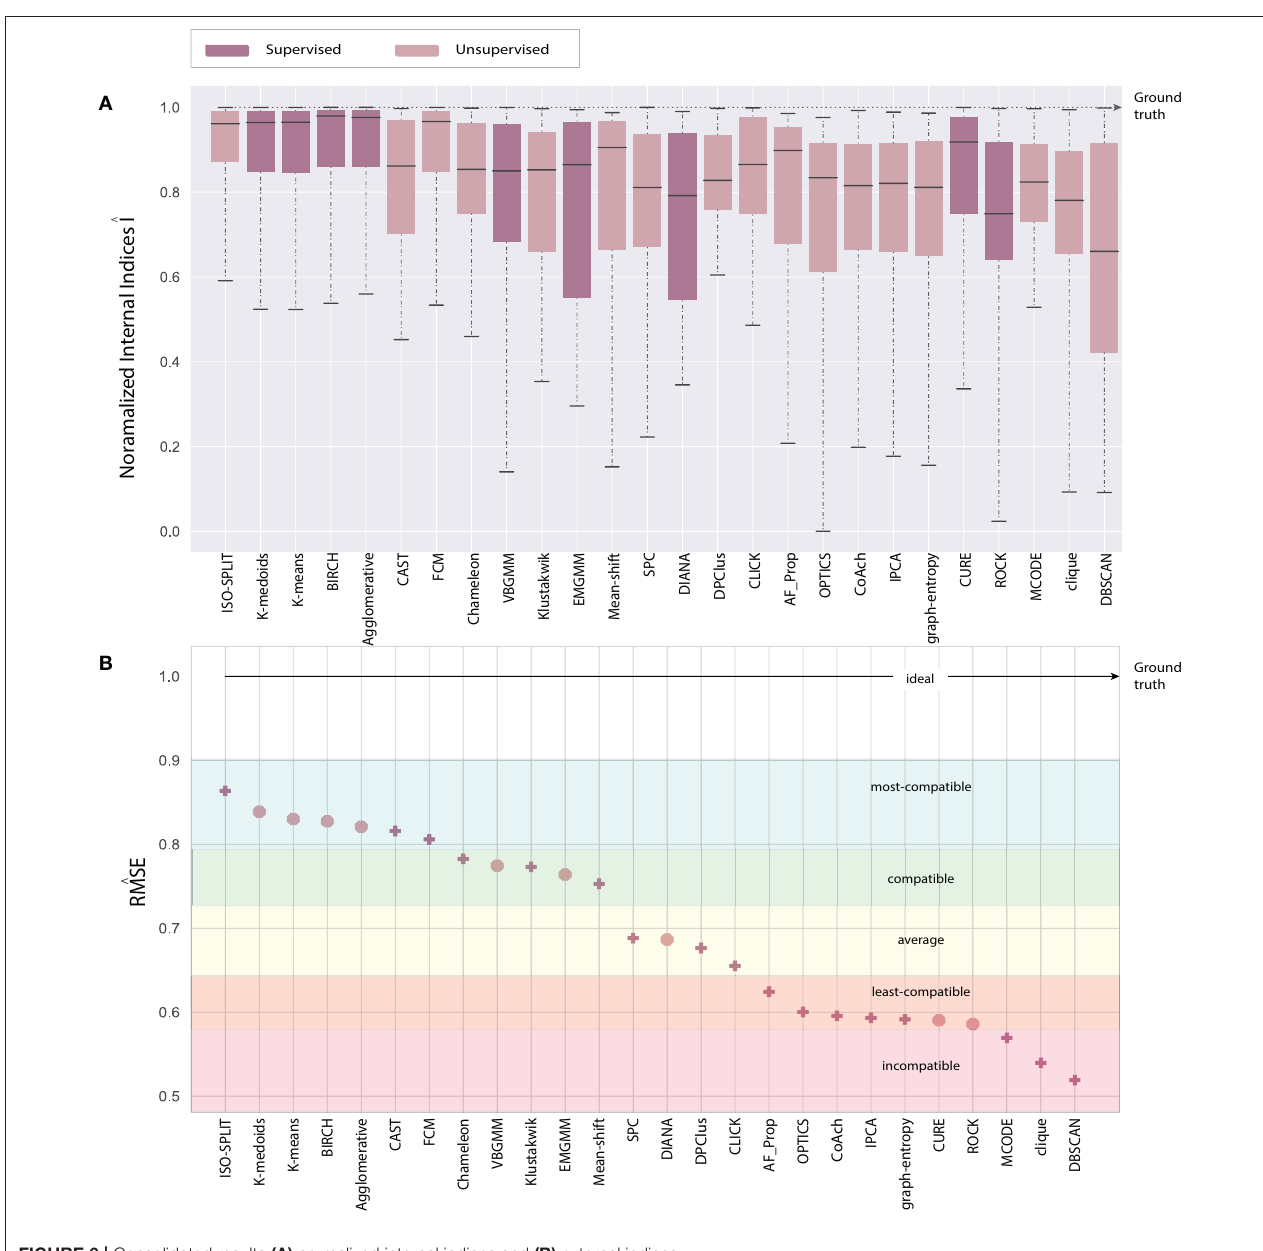
FIGURE 6 | Consolidated results (A) normalized internal indices and (B) external